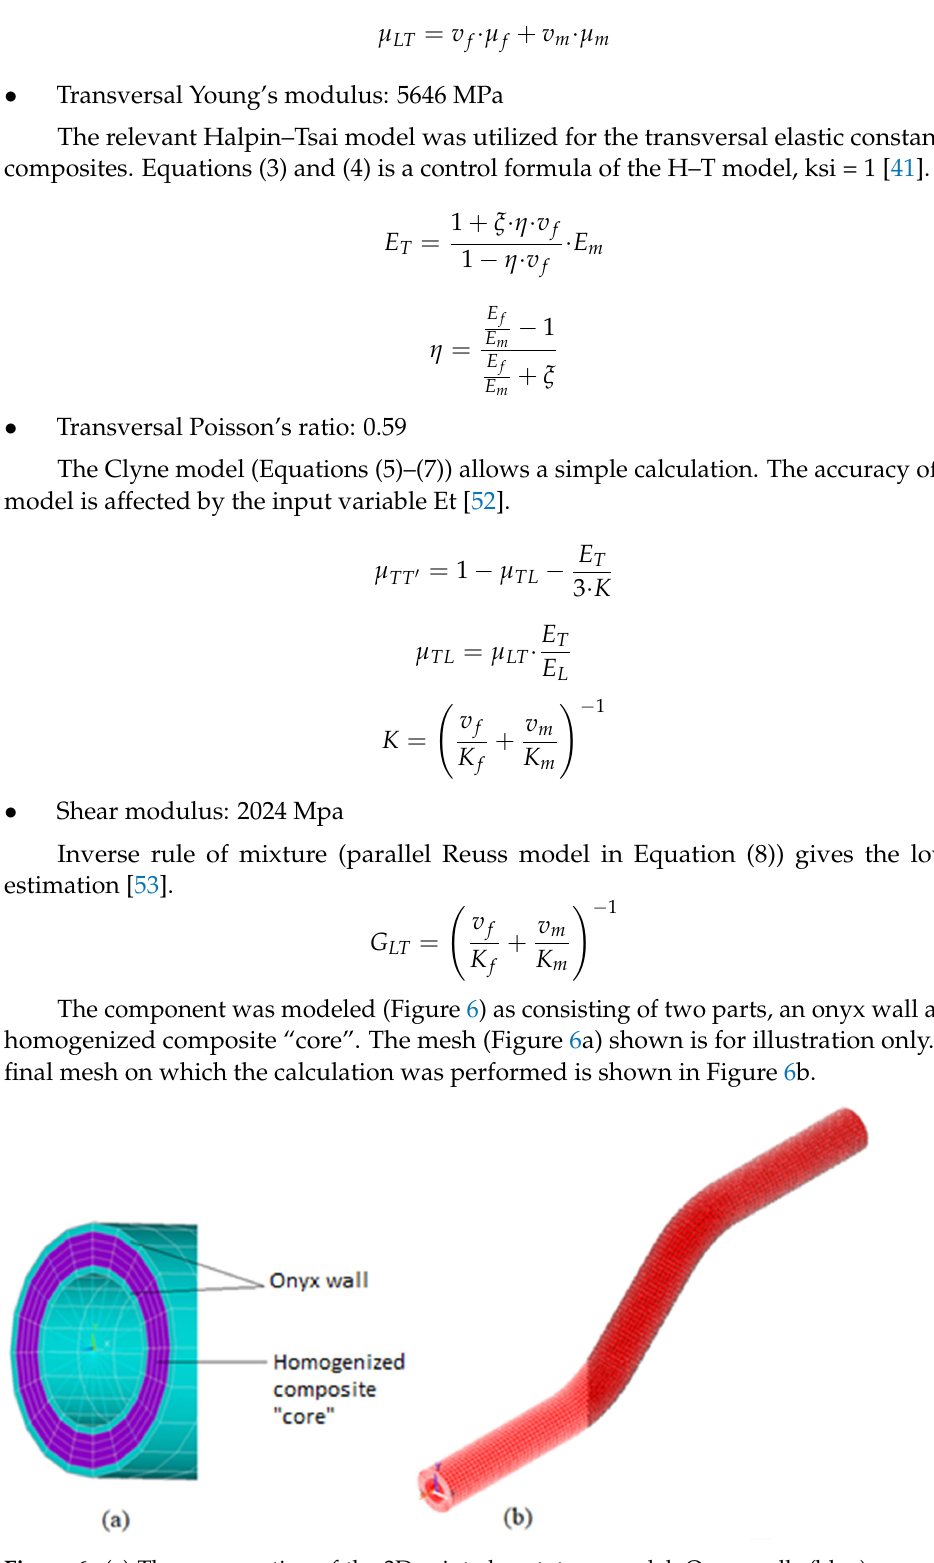
Figure 6. ( a ) The cross-section of the 3D printed prototype model; Onyx walls (blue), composite “core” (purple); ( b ) Final mesh of composite profile. Volumetric linear solid elements (Solid 185 in ANSYS library) were used in the mod- eling. Some boundary conditions also required the use of Multi-Point Constraint (MPC) elements, specifically MPC 184. The elementary coordinate systems of the composite part were rotated with respect the direction of the fibers. The boundary conditions were set to be as close as possible to the real situation during testing, as well as for the profiles pro- duced by manual methods. In Figure 7, the bottom part of the tube (the portion in the clamps) was fixed in all directions. Then, the top end of the tube was fixed in lateral di- rections and a compressive force was also applied. The sufficient mesh density was obtained and checked by a sensitivity analysis. The final mesh consisted of 28,512 elements and 43,020 nodes. Doubled element count led to marginal (0.1%) change in results, hence the depicted mesh was considered as sufficient. First, a Linear Buckling (LB) or Linear Bifurcation Analysis (LBA) was performed. In LBA, the structure is considered ideal, without any imperfections and material or geomet- ric nonlinearities. The result are the eigenvalues corresponding to the multipliers of the applied force when the loss of stability is reached, and the shapes of the individual modes of loss of stability (MLS). It is important to realize that MLS only shows the displacement ratios of the structure, and does not represent the real deformation of the structure under loss of stability. The MLS serves only to illustrate the expected deformation of the struc- ture at the edge of stability. From the above, it is clear that LBA overestimates the capacity of structures. In general, a minimum overestimation of 15% is reported. The degree of overestimation, however, depends on the geometry and simplifications of the structure.